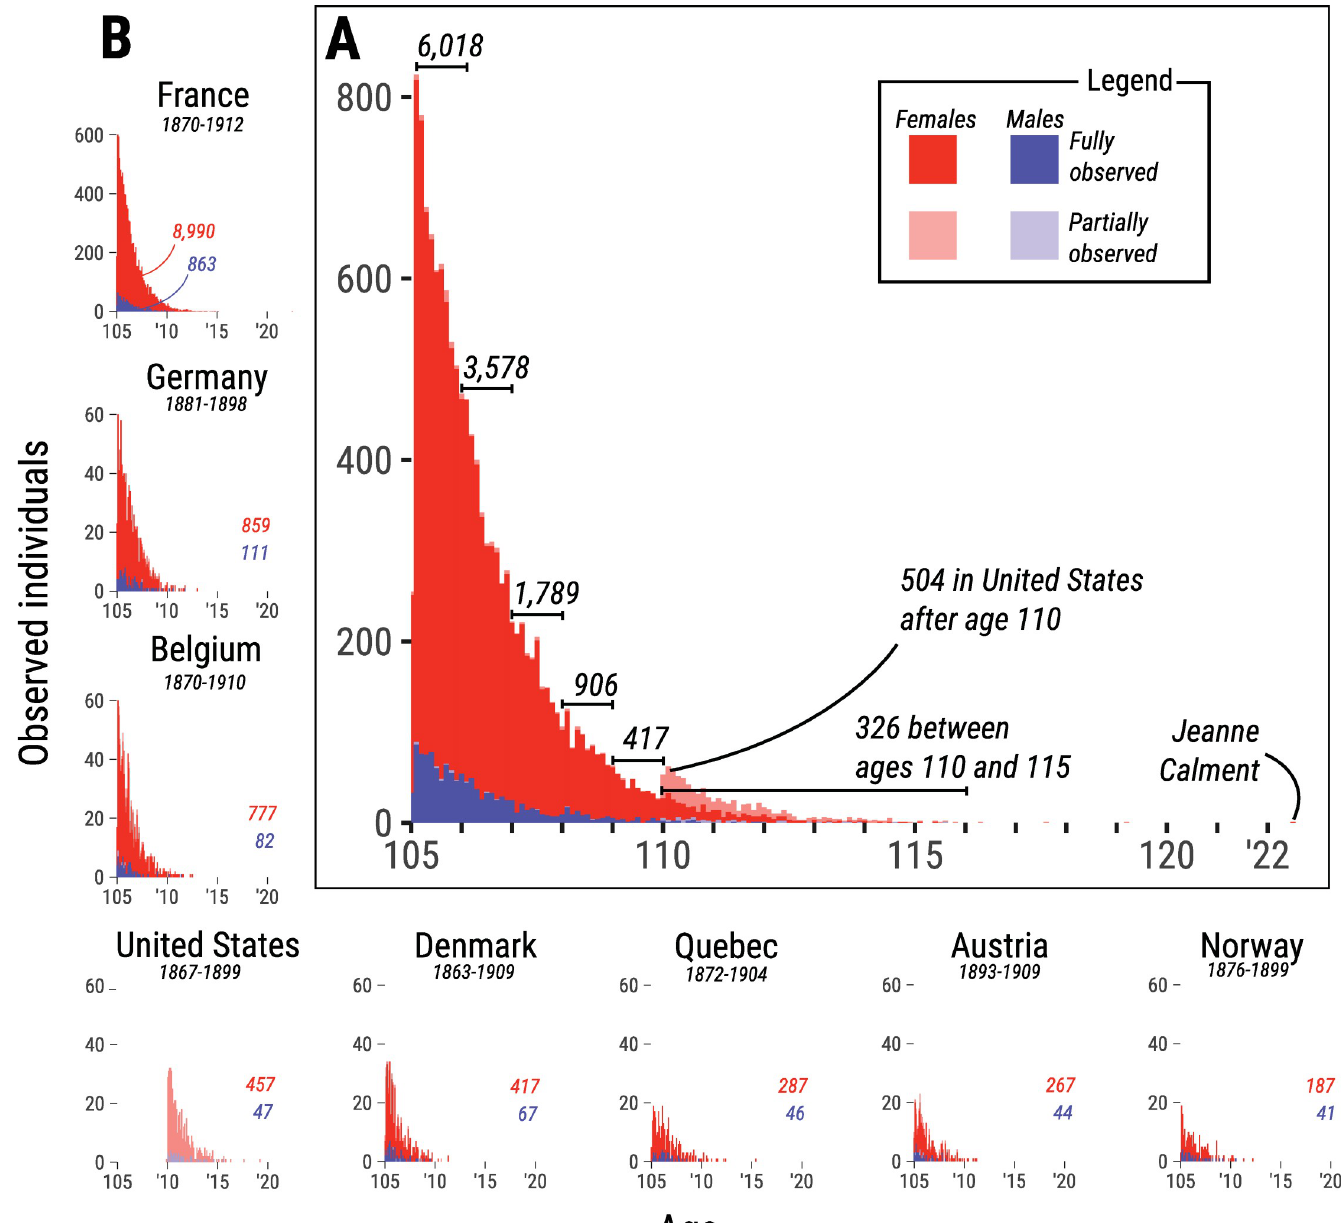
Fig 1. Histograms of individuals who reached age 105 reported in the International Database on Longevity, disaggregated by sex and observational scheme. ( A ) Histogram depicting the distribution of ages at last observation for all countries combined. ( B ) Close up to the distribution of ages at last observation by country and region. Red bars represent females and blue bars represent males. When the exact age at death is known, we regard an individual as fully observed and it is represented by solidly colored bars. Conversely, partially observed individuals are those whose exact date of death is unknown (e.g., right-censored or interval-censored) and they are depicted with lighter-colored bars. Birth cohorts of individuals included in the analysis are indicated below each country name.